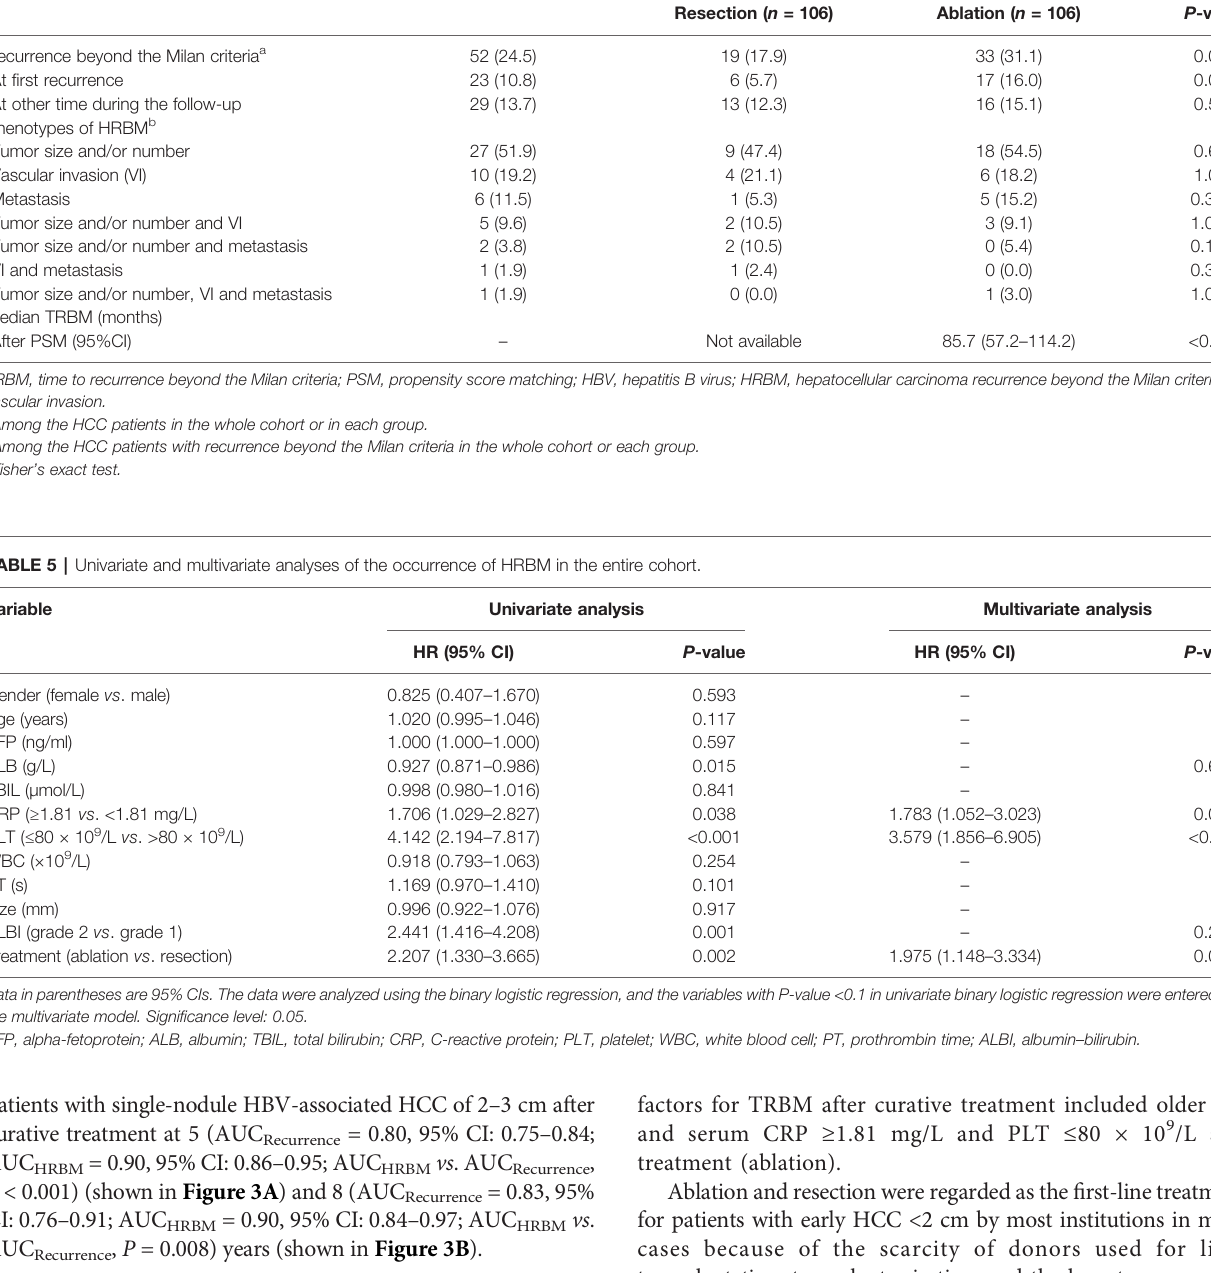
TABLE 4 | Patterns of HRBM after resection or ablation as fi rst-line therapy for patients with single-nodule HBV-associated HCC of 2 – 3 cm after PSM. Patterns of